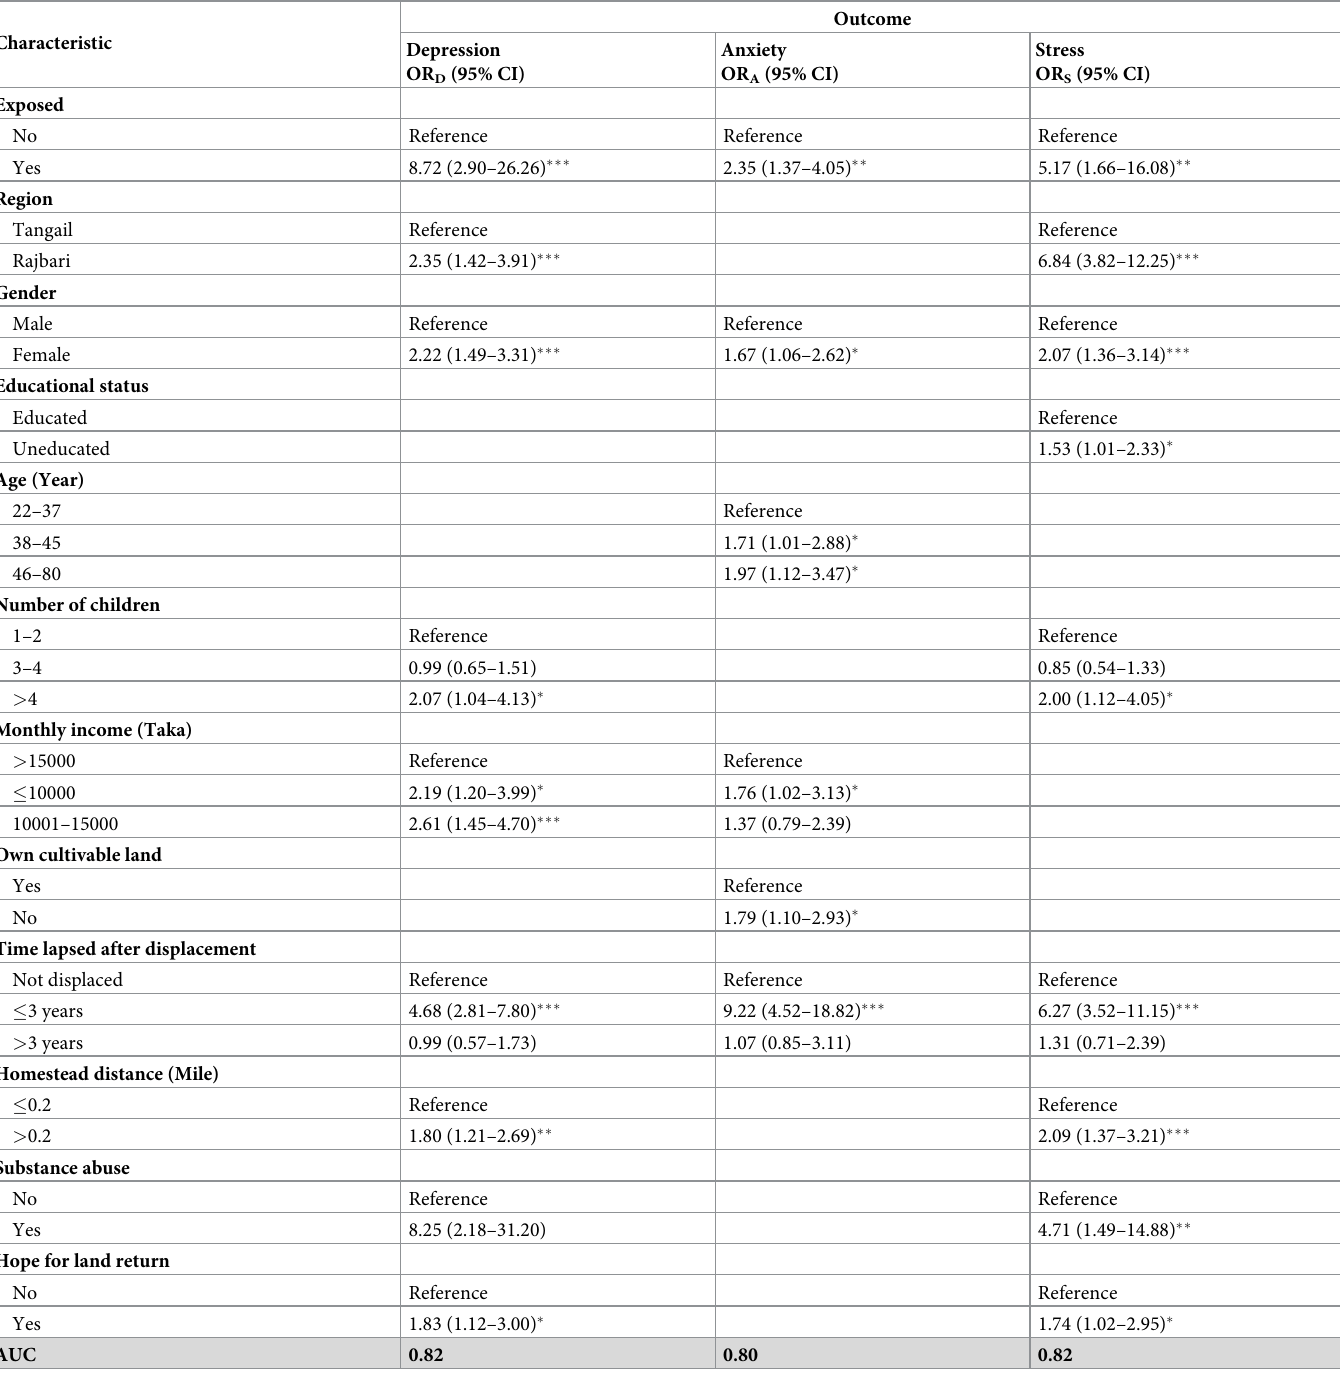
Table 3. Logistic regression final model showing the adjusted odds ratio of predictors of